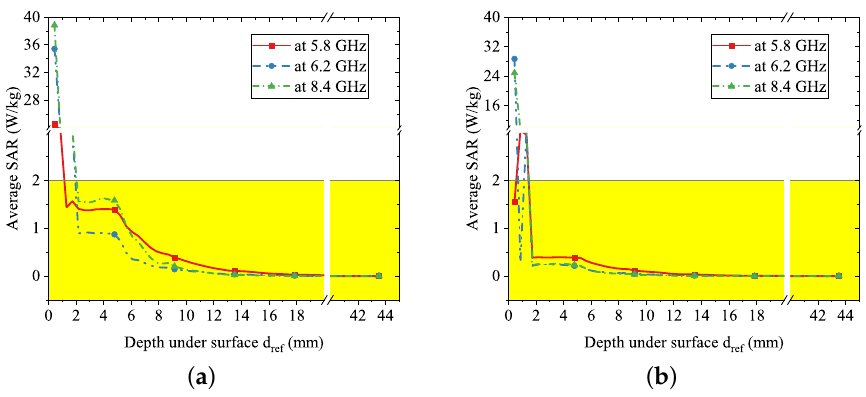
Figure 25. Average SAR vs. d ref along the reference line. ( a ) SAR on reference line for d ant = 0 mm; and ( b ) SAR on reference line for d ant = 10 mm.